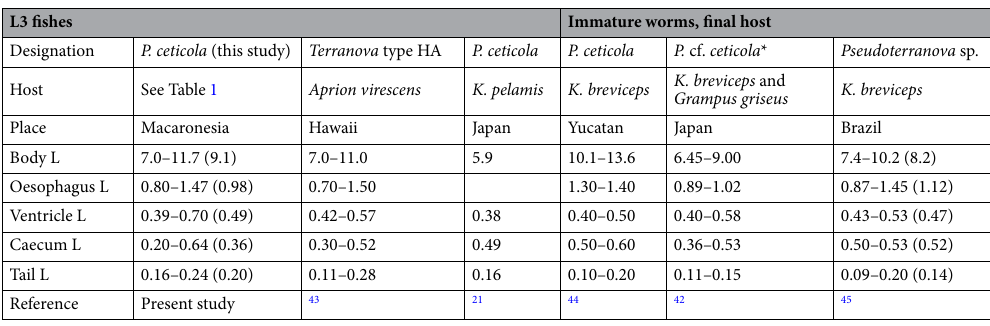
Table 5. Comparison of P. ceticola L3 with other similar larvae (range and mean in mm) and immature worms from kogiid whales. *Reported as third larval